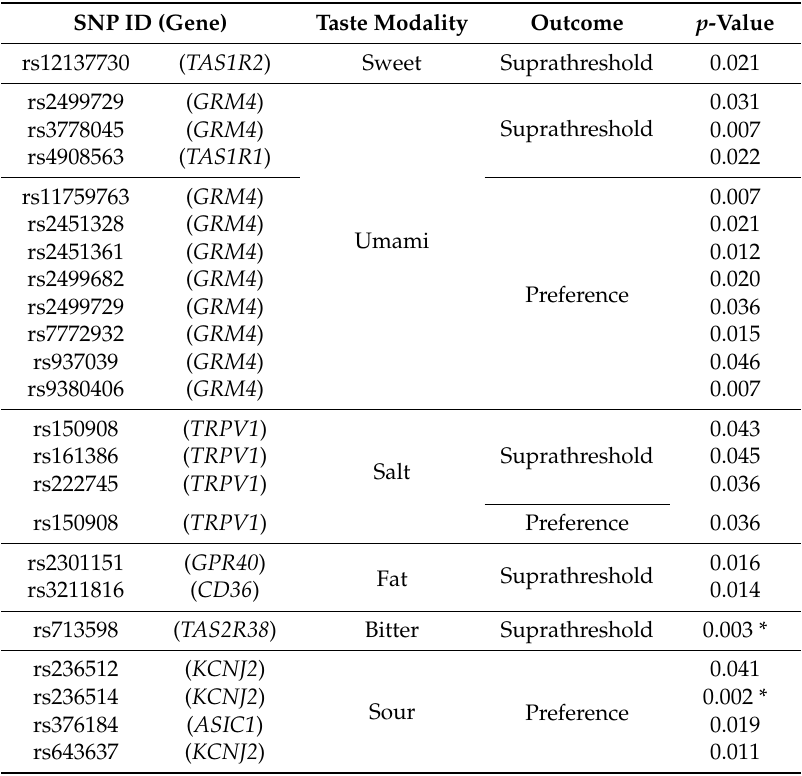
Table 4. Associations between single nucleotide polymorphisms (SNPs) in taste receptor genes and suprathreshold sensitivity and taste preference in adults.